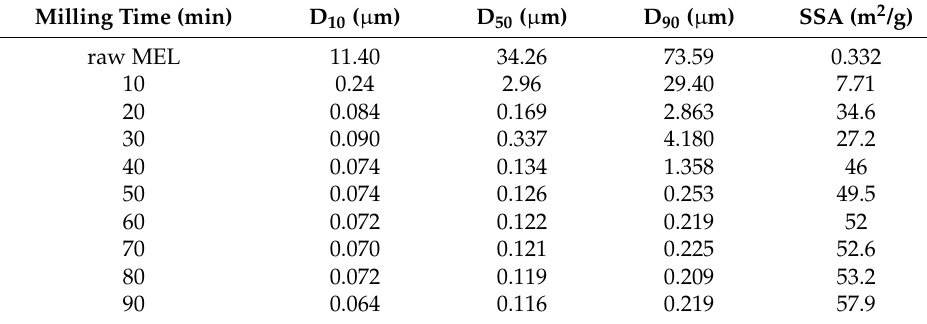
Table 2. MEL PSD and SSA in pre-dispersions containing PVA-solution as